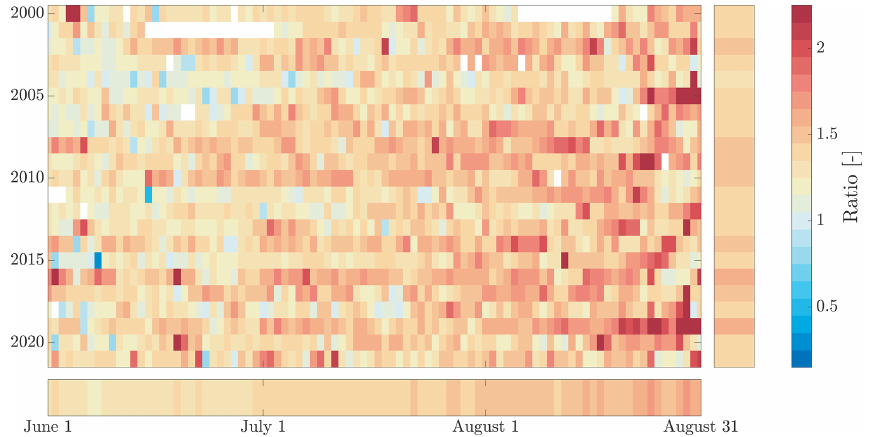
Figure 7. Ratio of daily parameterized meltwater production with observed albedo to parameterized meltwater production with modeled albedo. The vertical and horizontal bars show annual and seasonal